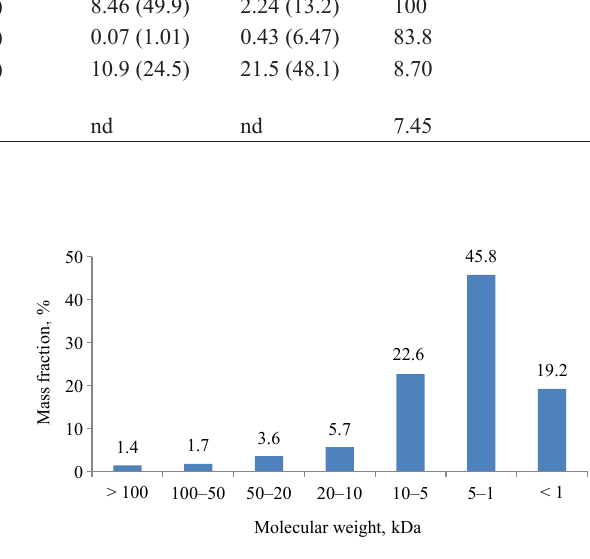
Table 3 Chemical composition of raw materials and fractions obtained after enzymatic-thermal hydrolysis of sockeye heads Sample